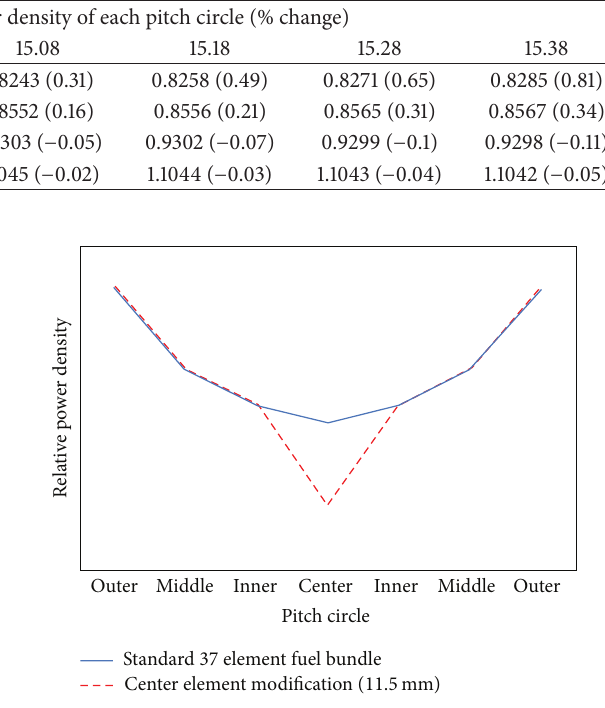
Figure 5: Normalized axial flux distribution (AFD) of a 37S fuel bundle and center element modifications.